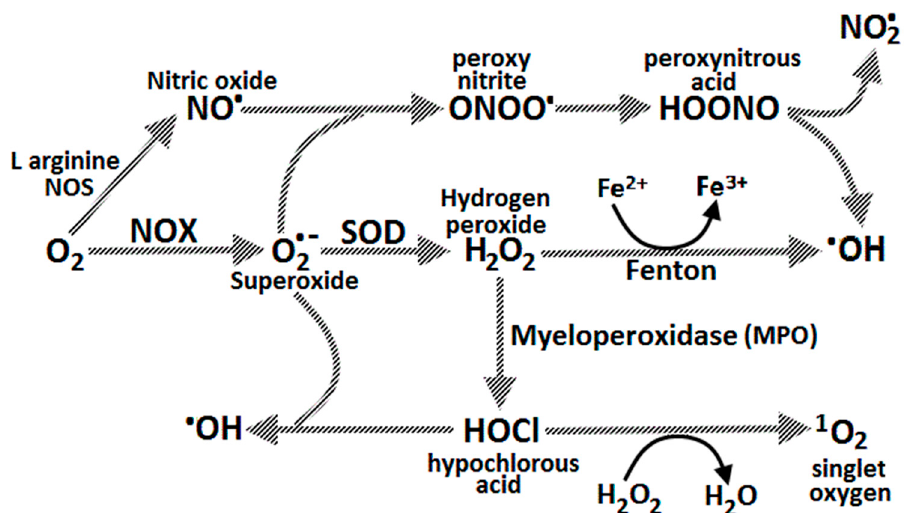
Figure 6. The three sources of DNA damaging hydroxyl radicals; from nitric oxide (NO) reacting with superoxide radicals to form peroxynitrite, from Fenton reactions with hydrogen peroxide (H 2 O 2 ) and ferrous iron, or from superoxide reacting with hypochlorous acid (HOCl) from neutrophils. Nitric oxide synthase (NOS), Superoxide dismutase (SOD), NADPH oxidase (NOX), hydroxyl radical (OH · ). Adapted from Knaapen et al. with permission [76].